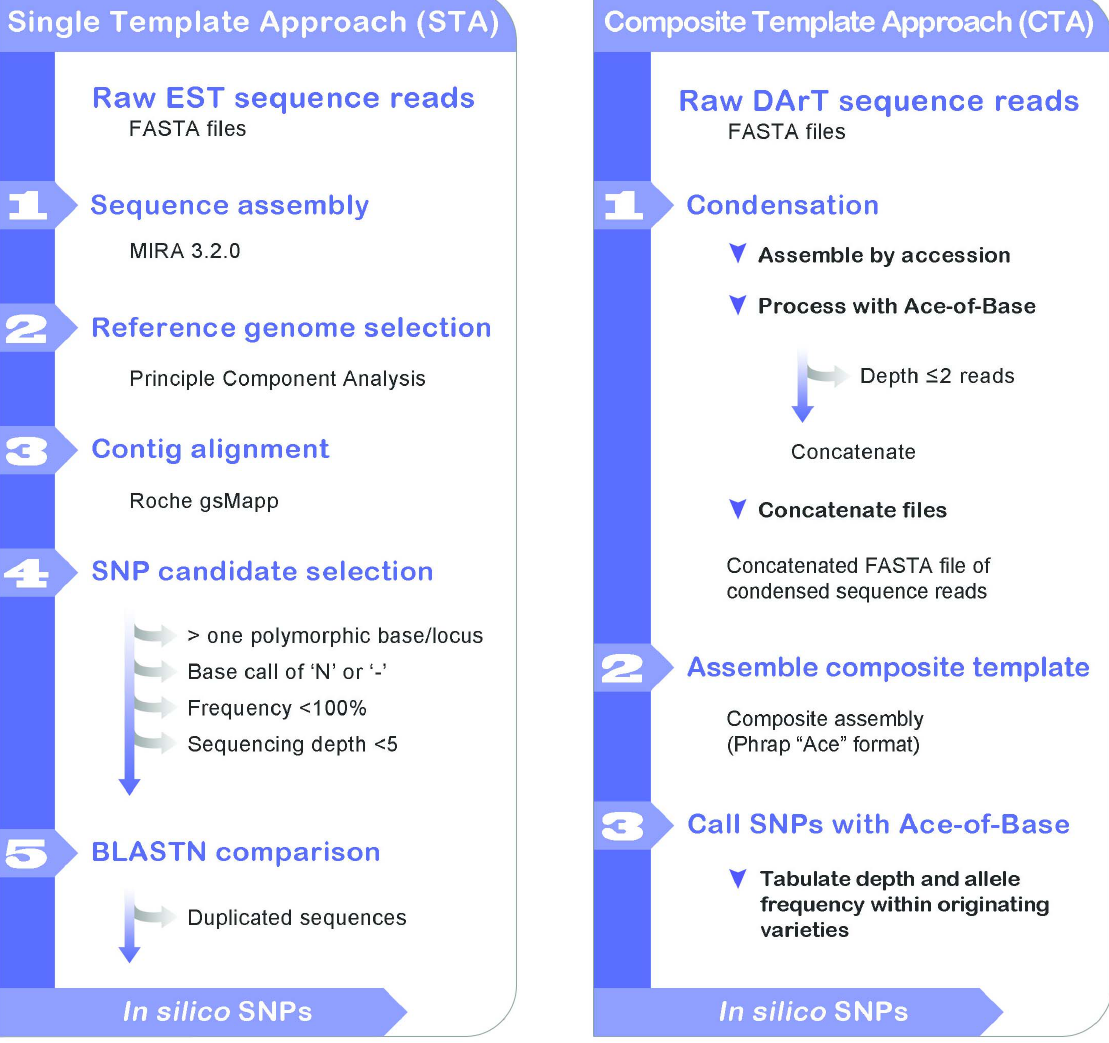
Figure 1. Insilico SNP discovery approaches. Both methods started with a set of quality-trimmed 454 sequence reads identified by source germplasm from either the cDNA libraries or from DArT-based genomic complexity reductions. A. In the single template approach (STA), the reads were assembled by MIRA software to generate a consensus sequence for each contig. Four reference genomes were selected based on membership in four different quadrants of a principle component analysis that had been conducted previously using DArT markers. Consensus sequences from all varieties were assembled against each of the four reference genomes, and candidate SNPs were called using Roche GSMapper. SNPs were filtered based on several criteria, as described in the methods. Redundant SNPs were identified using BLASTN. B. In the composite template approach (CTA), reads were assembled within varieties at a high stringency using DNAstar Seqman Software. Then the consensus reads were filtered and truncated to include only those parts having perfect alignment with greater than two reads. The consensus reads were then concatenated and subjected to a single composite assembly at lower stringency. The consensus from this assembly was used as a composite reference genome to call SNPs. Although the SNP calling and filtering process was similar to CTA, this pipeline was automated using in-house software called